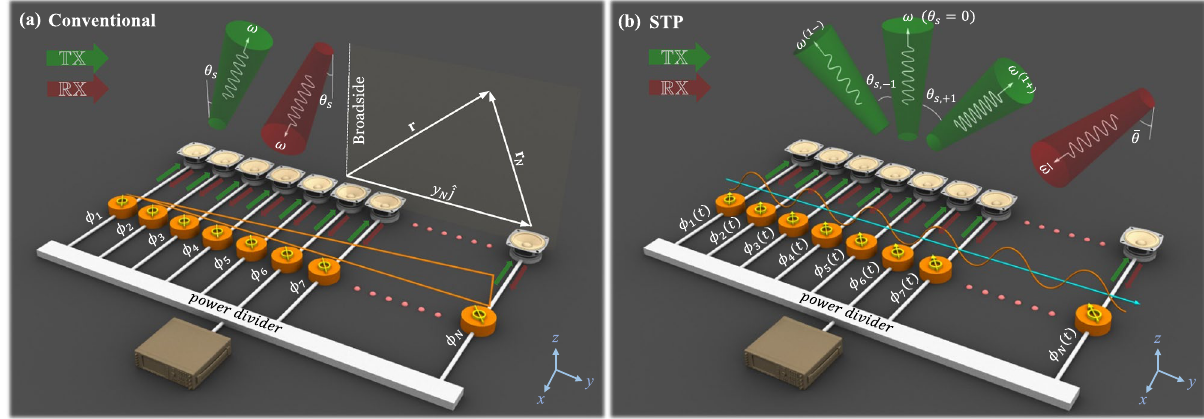
Figure 1. Acoustic phased arrays. ( a ) Conventional phased array in TX / RX modes with a static phase gradient. ( b ) STP phased array in TX / RX modes with a dynamically changing phase gradient. Green and red colors denote transmitted and incident waves,